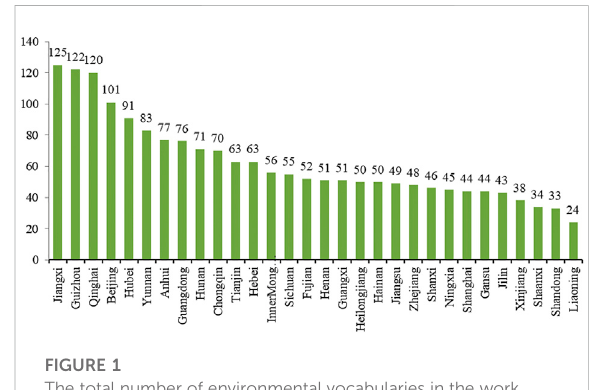
FIGURE 1 The total number of environmental vocabularies in the work reports of the provincial governments from 2009 to